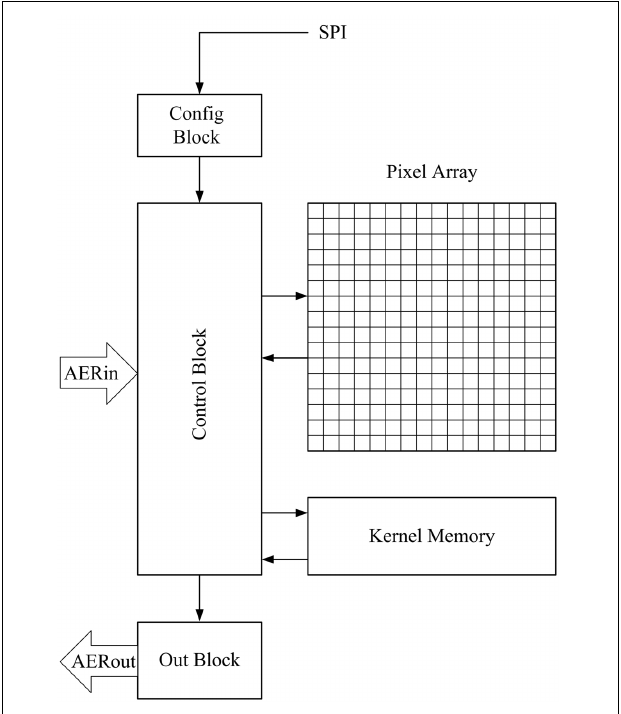
FIGURE 6 | Block diagram for the convolutional block implemented on